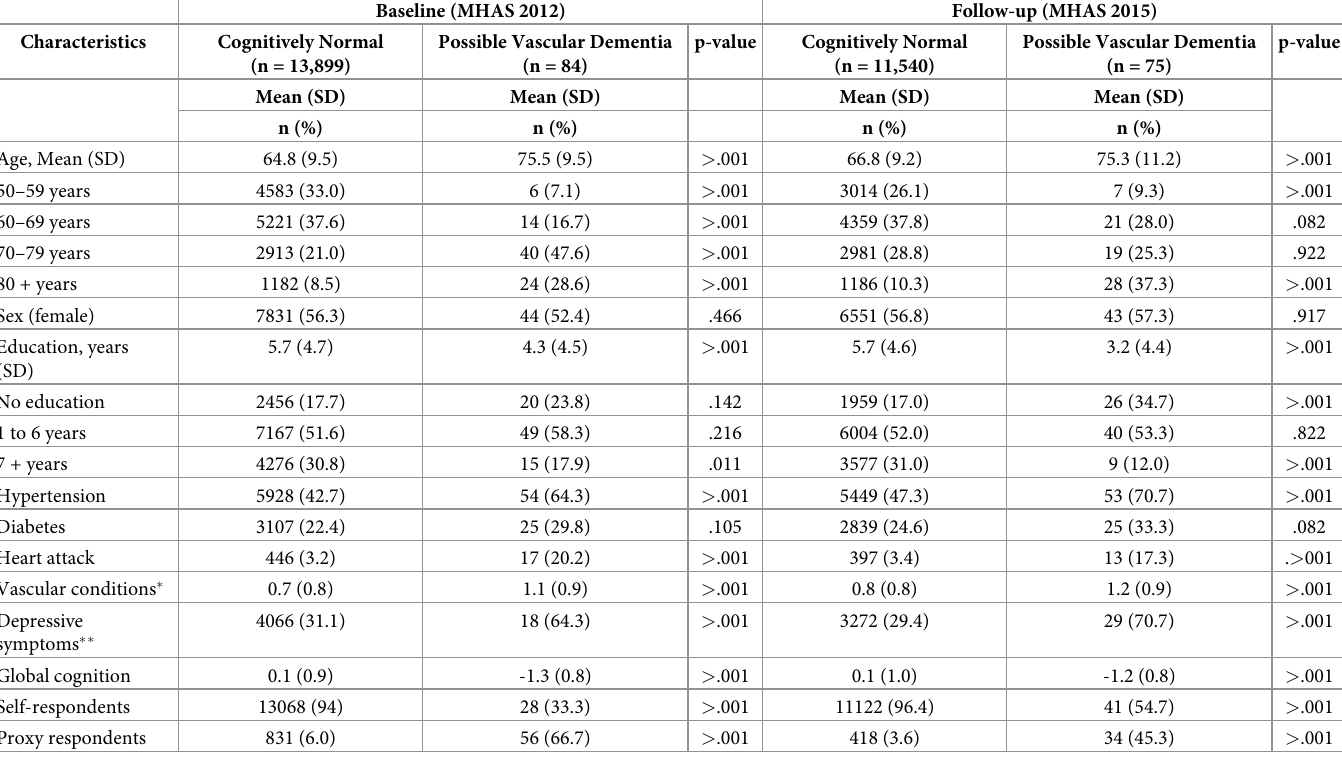
Table 1. Characteristics of the MHAS sample at baseline (2012) and follow-up (2015) by diagnostic group. Baseline (MHAS 2012) Follow-up (MHAS